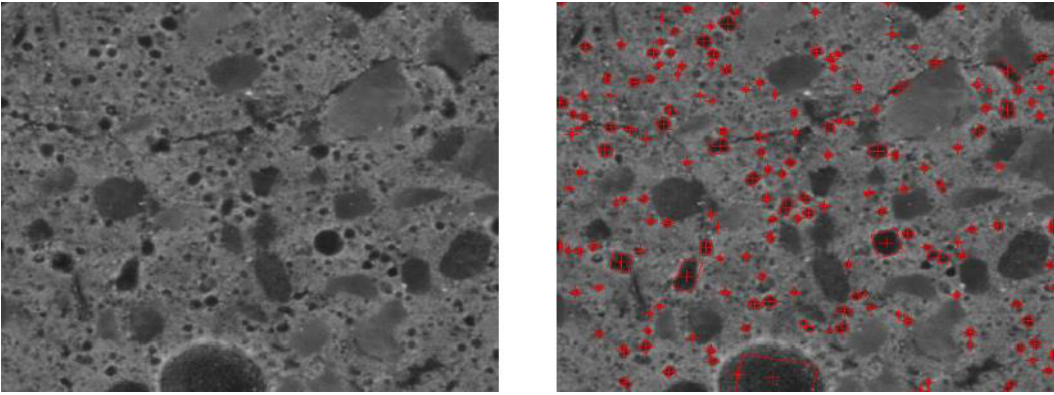
Figure 1. Image analysis process.